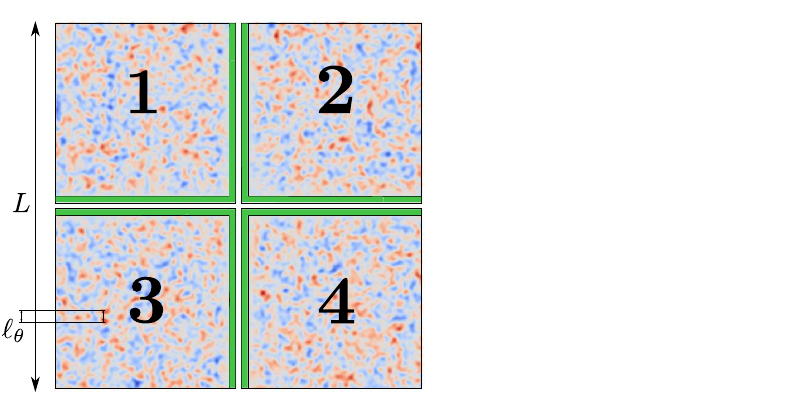
Figure 7. Generation of four independent realizations G i ( x ) on local supports Ω i . The green band represents the overlapping region, i.e., the support of the weighting functions φ i